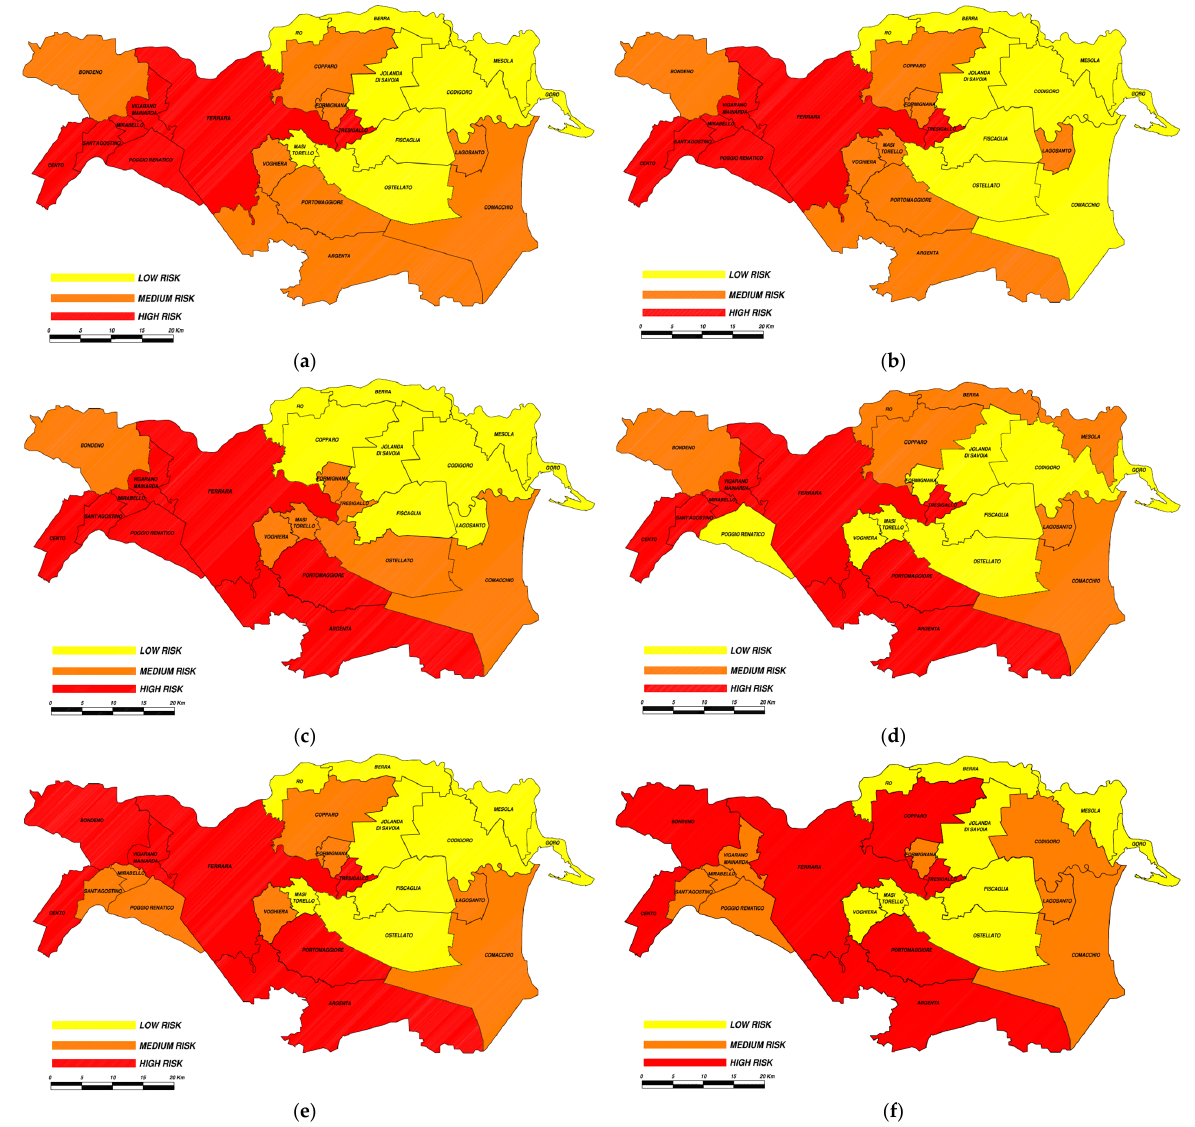
Figure 13. Weights sensitivity analysis, multi-risk maps; ( a ) flood hazard weight increase assuming Scenarios 2 or 3; ( b ) PGA weight increase assuming Scenario 1; ( c ) PGA weight increase assuming Scenario 2; ( d ) land use weight increase assuming Scenarios 2 or 3; ( e ) strategic buildings weight increase assuming Scenario 1; ( f ) strategic buildings weight increase assuming Scenarios 2 or 3. The risk levels strictly indicate the relative priority ranking for decision-makers and do not indicate the effective safety level of the various municipalities.